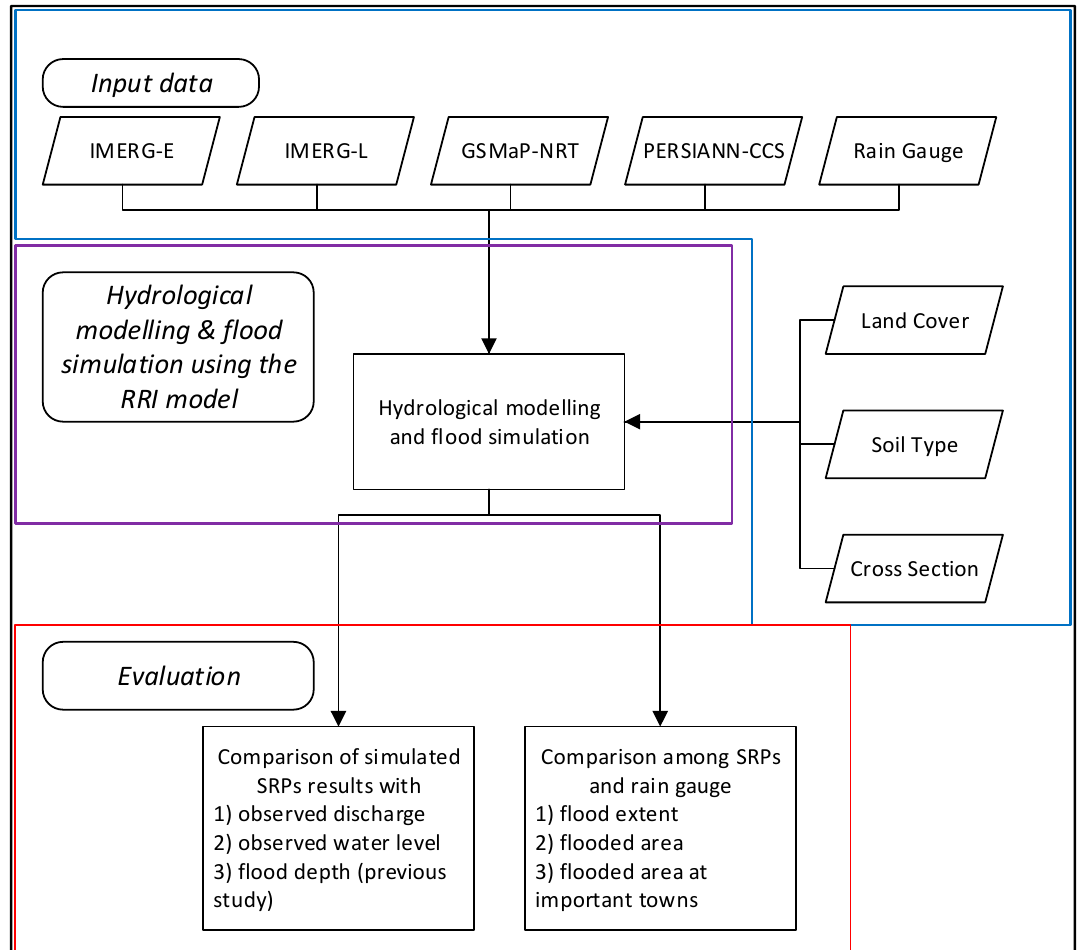
Figure 2. Flowchart of the methodology used in the present study.